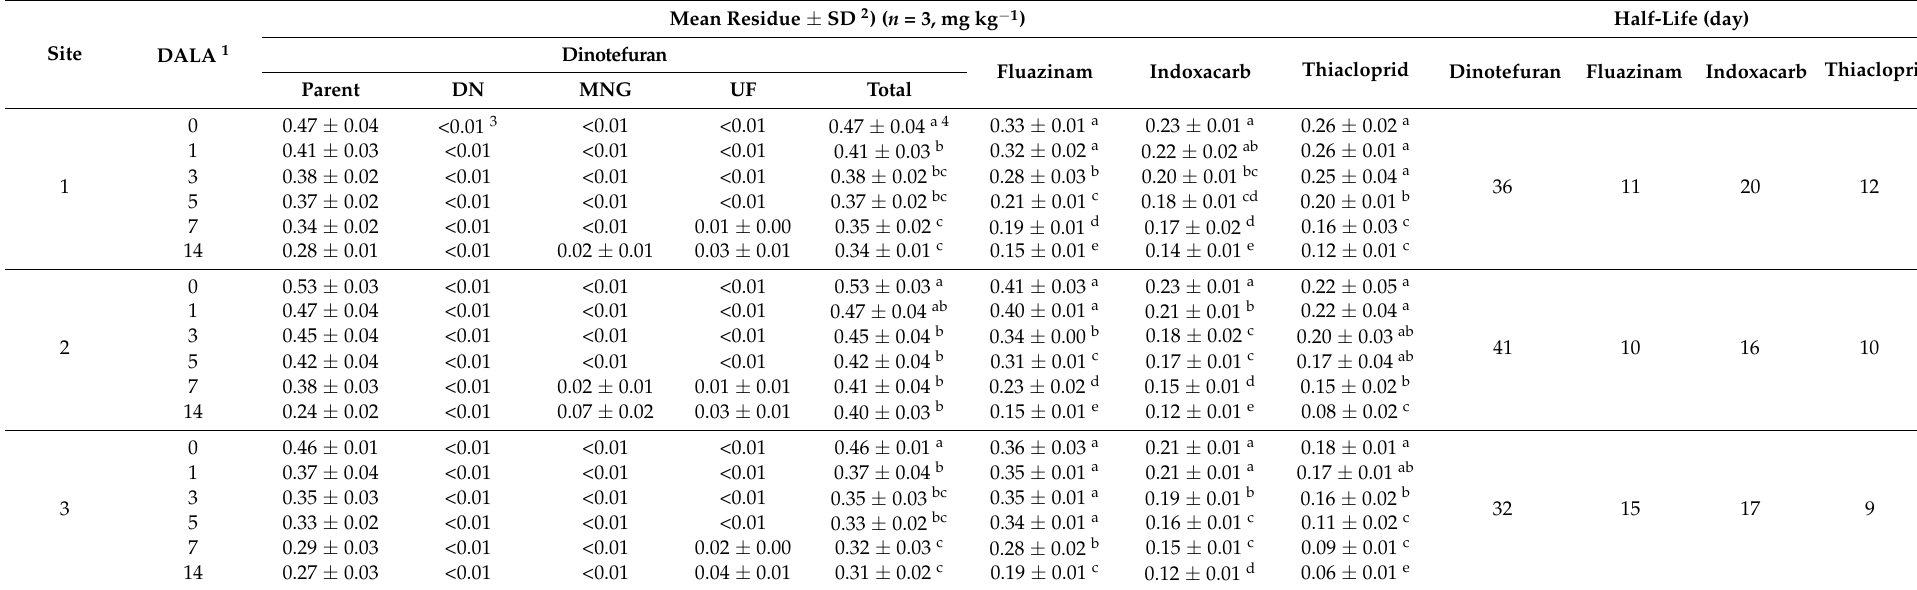
Table 4. Dissipation residue of test pesticide and their half-lives in fresh persimmon in site